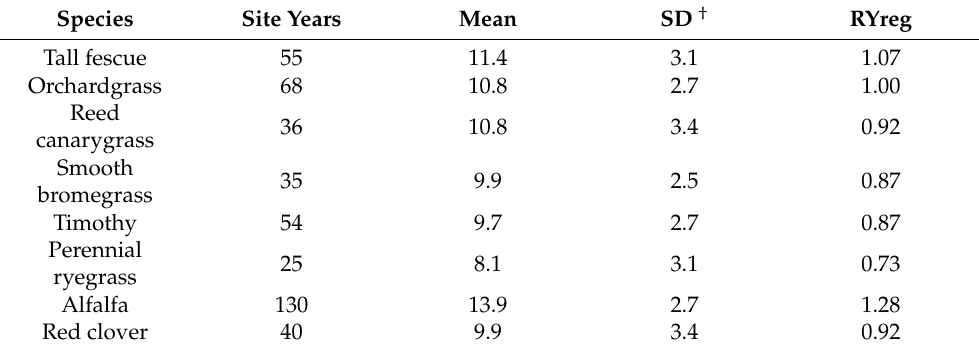
Table 4. Yield (MT · ha − 1 ) of grass (fertilized with 200 kg · N · ha − 1 ), alfalfa, and red clover hay in variety trials in West Virginia, Virginia, Pennsylvania, and Kentucky and relative yield compared by linear regression (RYreg) to orchardgrass growing on the same site in the same